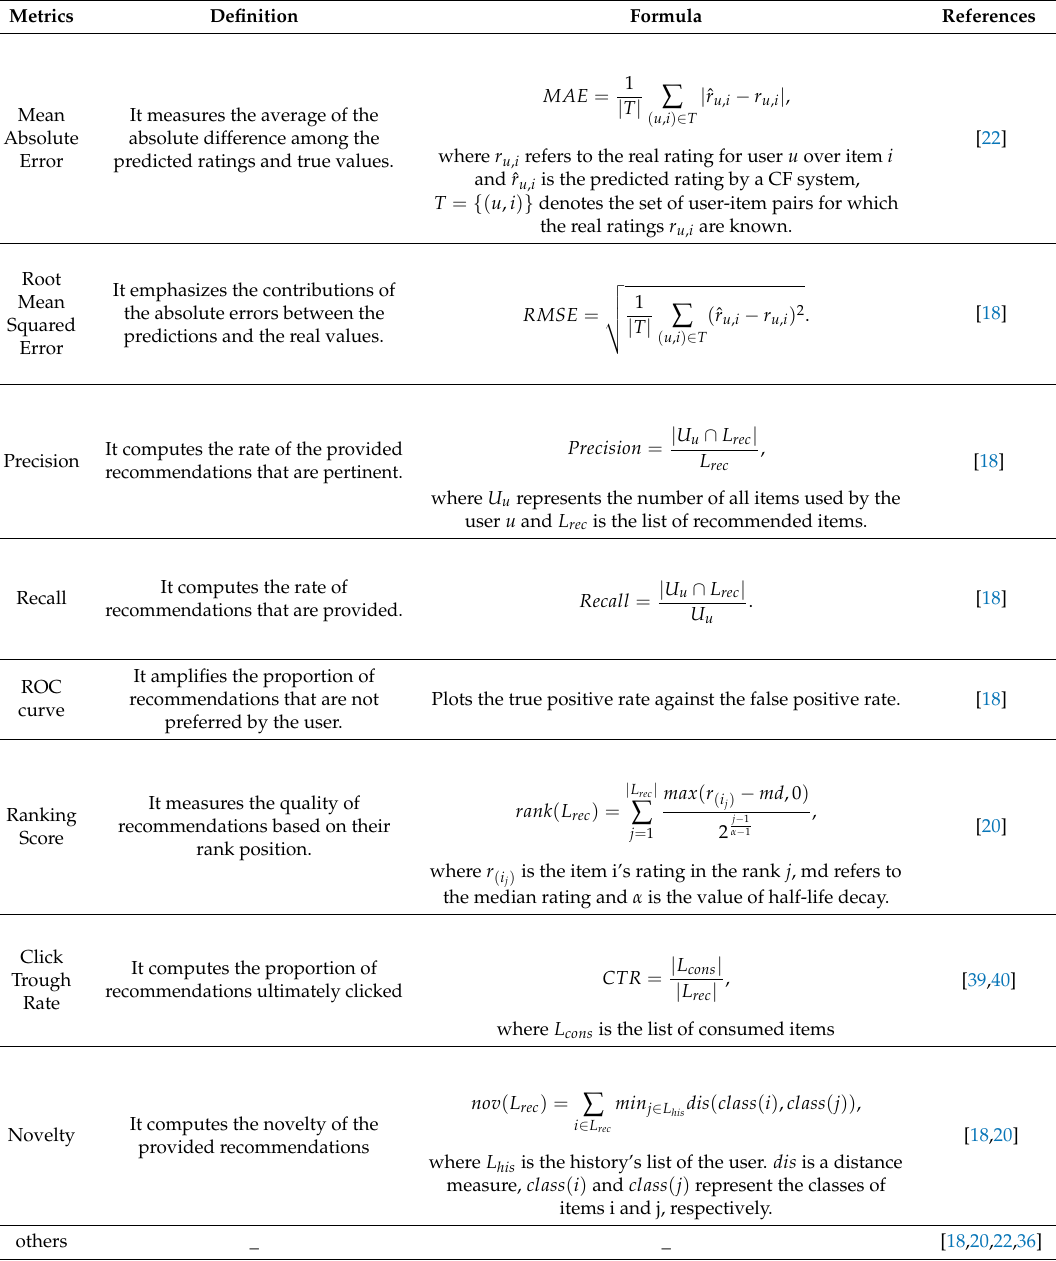
Table 2. Evaluation metrics used in